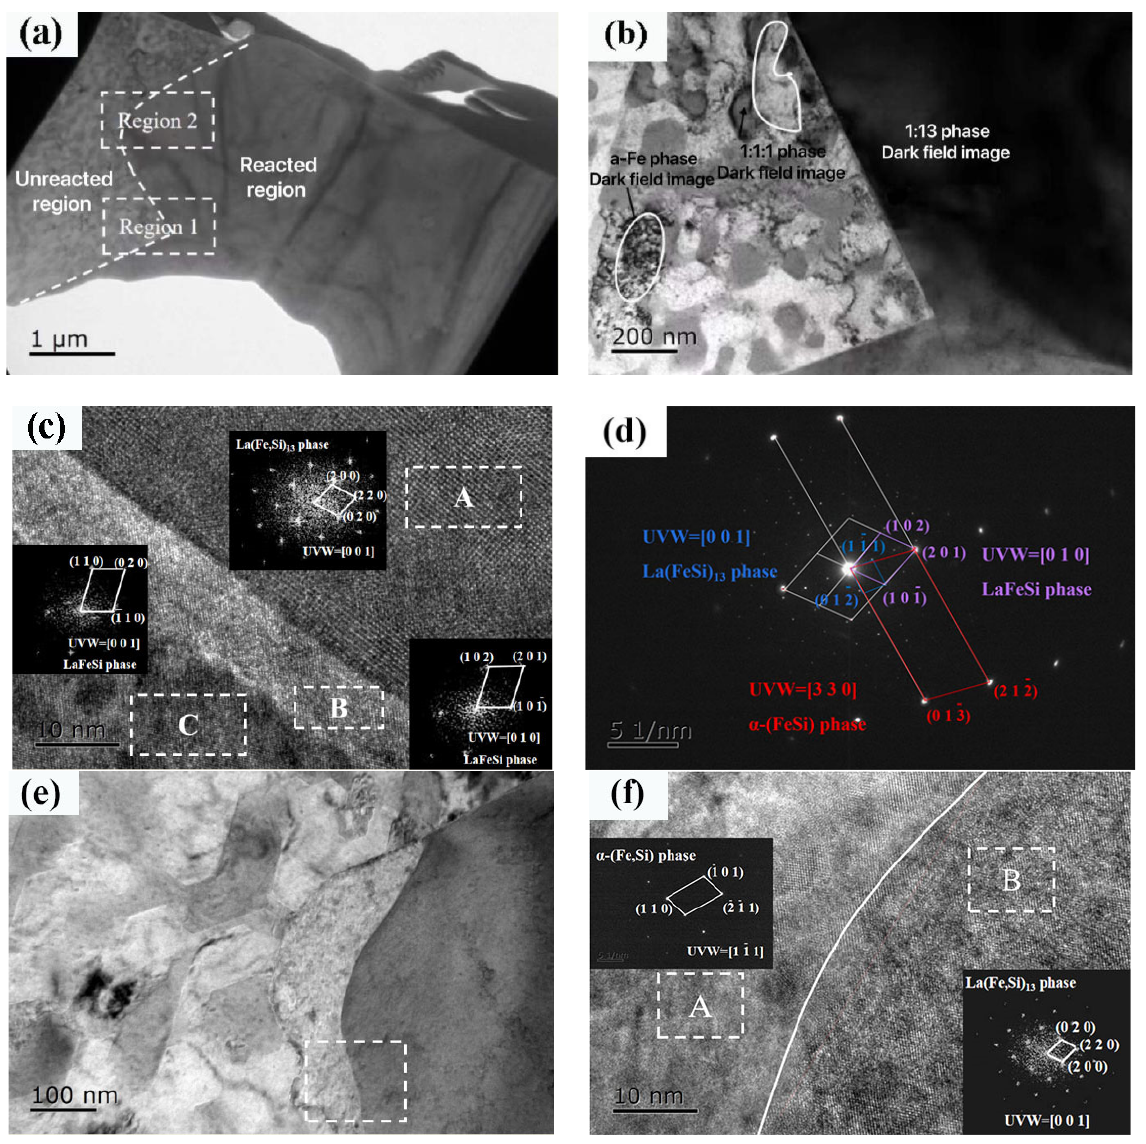
Figure 6. ( a , b ) Microstructure morphology ( c , f ) HRTEM micro-graph; ( d ) Fourier transform; ( e ) display of selected area in TEM of 35 m/s LaFe 11.5 Si 1.5 C 0.2 ribbons near the free surface annealed at 1273 K for 2 h.